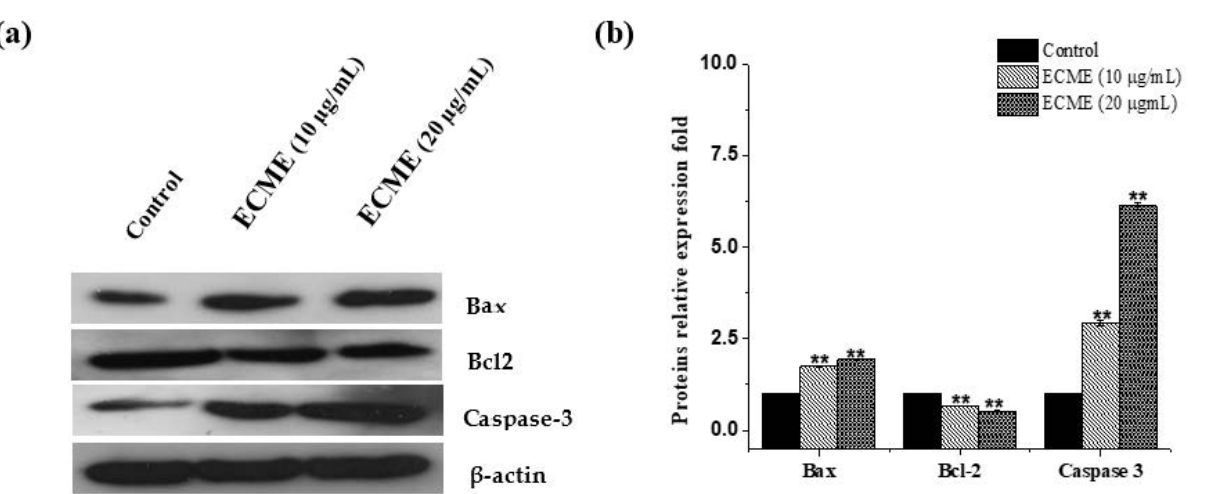
Figure 6. Effect of ECME on protein levels of proapoptotic and antiapoptotic proteins. A549 cells were treated with vehicle (0.01% DMSO) or at two effective concentrations of ECME for 48 h. (a) Immunoblot analysis displaying expression levels of Bax, Bcl-2 and Caspase-3. (b) Graph depicting the relative intensity of studied proteins versus ECME concentration. The data is the average of three experiments with standard deviation. ** p < 0.01 vs. the control group.